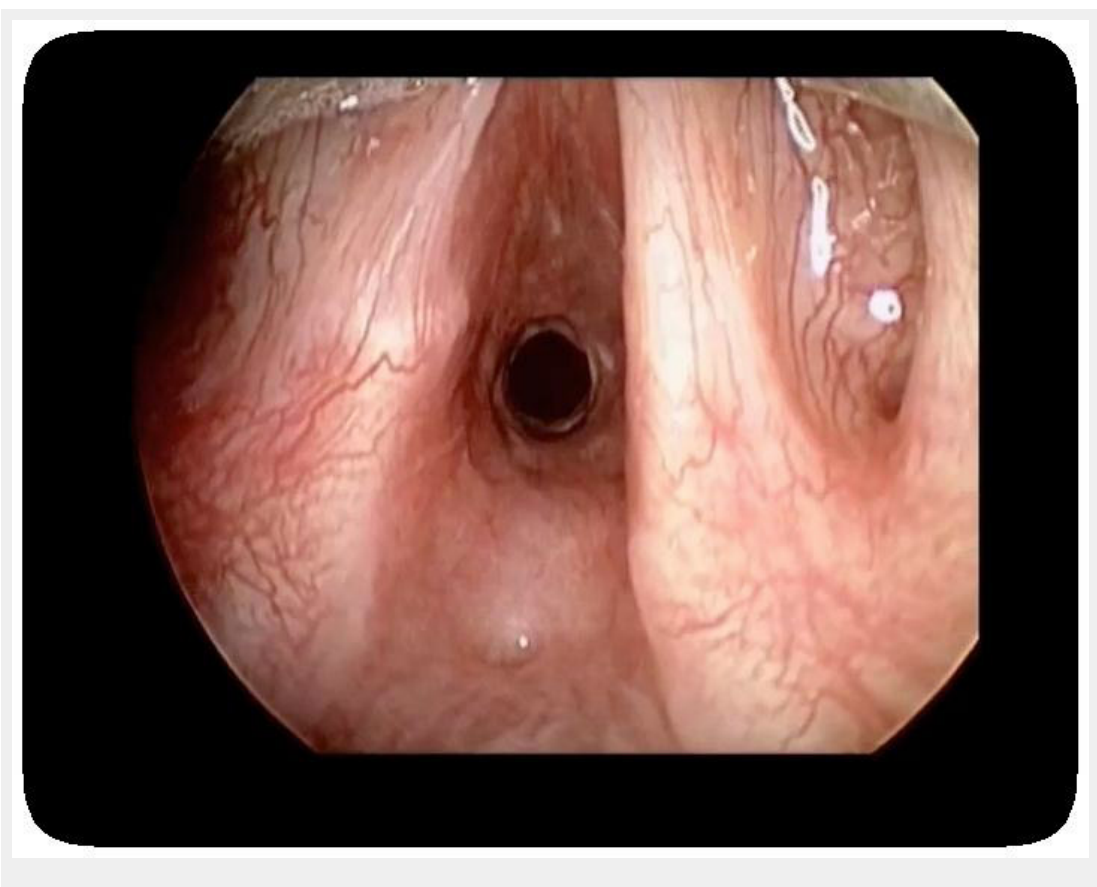
Figure 5 Direct laryngoscopy intraoperative view of subglottic stenosis in a patient with GPA (reprinted from Wolter NE, Ooi EH, Witterick IJ. Intralesional corticosteroid injection and dilatation provides effective management of subglottic stenosis in Wegener’s granulomatosis. Laryngoscope. 2010;120(12):2452–5. © 2010, with permission from John Wiley &